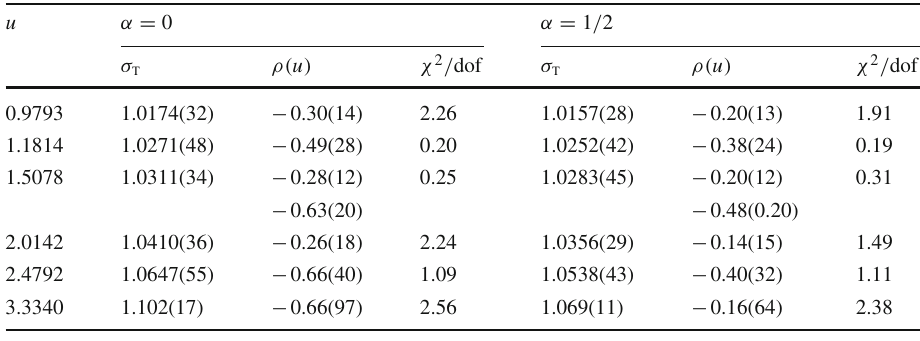
continuum-extrapolated values of σ T with subtraction of perturbative cutoff effects. The two lines for u = 1 . 5078 correspond to the use of the one- and two-loop value of c t , respectively